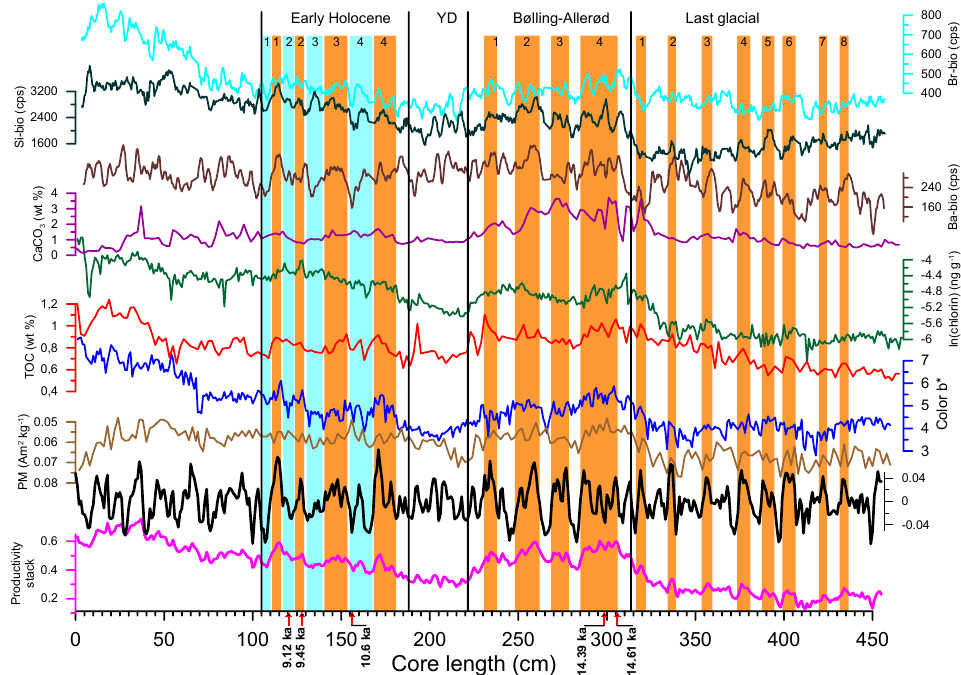
Figure 2. Records (from bottom to top) of the original and detrended productivity stacks, PM, color b ∗ , TOC, chlorin, CaCO 3 , Ba-bio, Si-bio, and Br-bio versus depth. Preliminary boundaries of the B/A warming, YD cooling, and Holocene are shown according to general variability in productivity in the NW Pacific, Sea of Okhotsk, and Bering Sea (Galbraith et al., 2007; Gorbarenko, 1996; Gorbarenko and Goldberg, 2005; Keigwin, 1998; Seki et al., 2004). AMS 14 C data (calendar ka) are shown at the base. Blue bars indicate cold periods/lower- productivity events. Orange bars indicate warm periods/high productivity